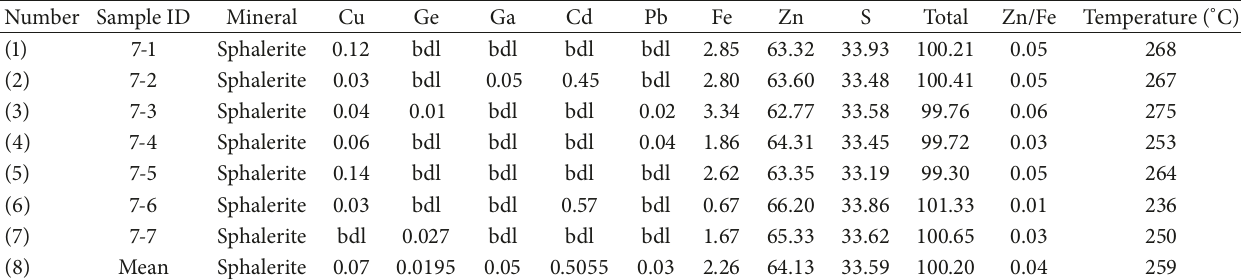
Table 5: Representative EMPA data (in wt.%) of sphalerite from the Zhijiadi Ag-Pb-Zn deposit. Number Sample